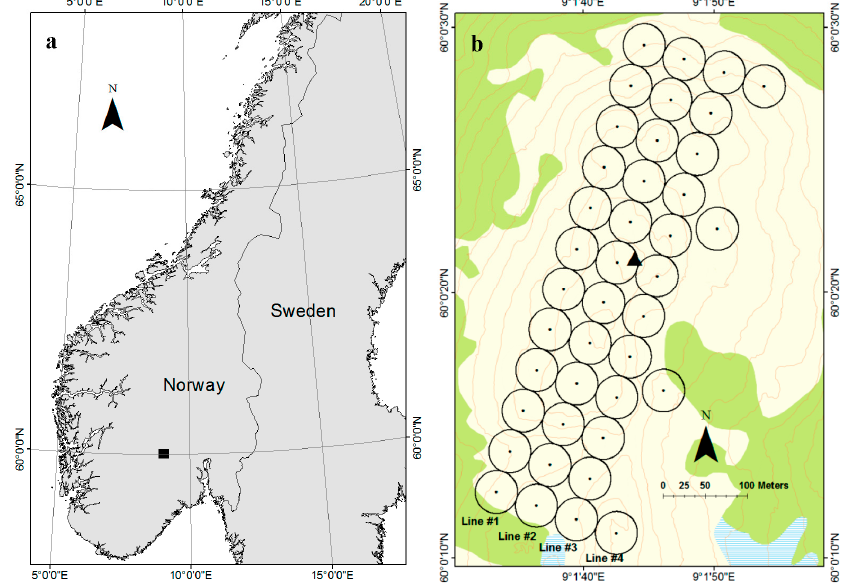
Figure 1. ( a ) Location of the study area in southern Norway (black square); and ( b ) Design of the trial. The PCQ sample points are marked as black dots and are the centers of the plots with radius 25 m arranged along four sample lines. The green area is defined as forest according to the official N50 topographic map series. Accordingly, the light area is above the tree line. The black triangle shows the location of the national reference point of the Norwegian Mapping Authority (60°00 ′ 21.10929 ″ N 9°01 ′ 43.97760 ″ E, 951.904 m above sea level) used as location of the base station for the real-time positioning.